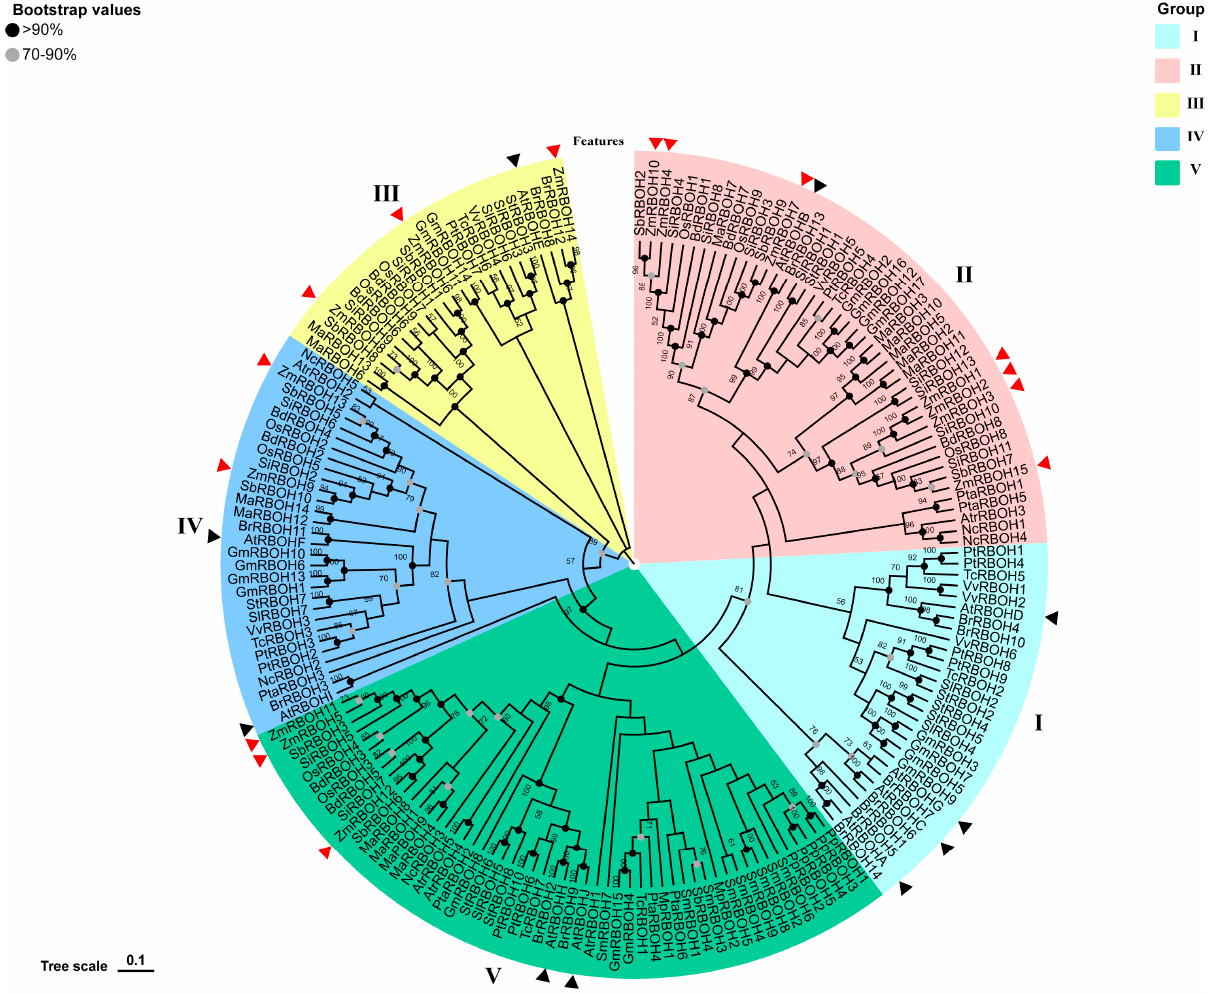
Figure 3. Phylogenetic relationship of plant RBOH family members. Five subgroups are indicated with I–V, respectively. Triangles in red and black color indicate ZmRBOHs and AtRBOHs , respec- tively.